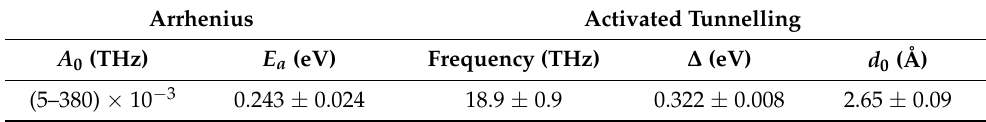
Table 2. Derived Arrhenius and activated tunnelling parameters pertinent to the γ relaxation.